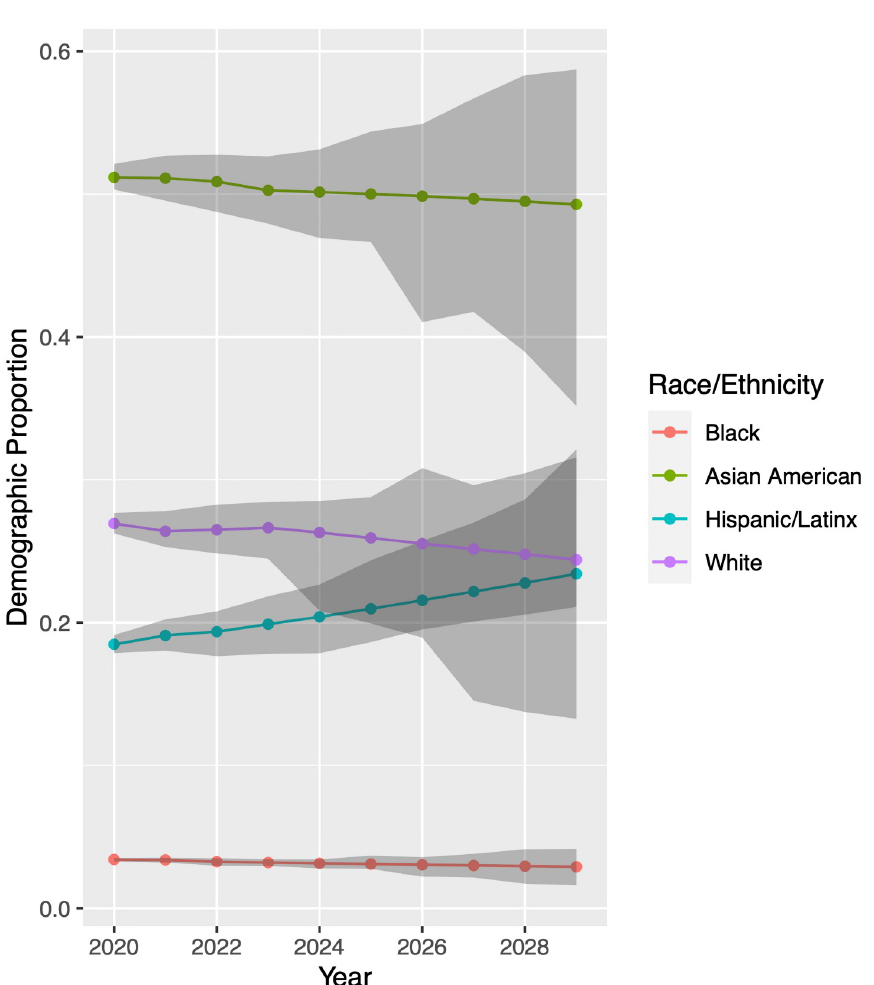
Fig 7. Model predictions for University of California-Berkeley. While the uncertainty in prediction is large after four to five years due to the difficulty in extrapolating model input parameters, two trends are clear. The proportion of Hispanic/Latinx students will rise, and the proportion of Black students will remain quite low. Colored dots are model output obtained when using the parameters forecast in Inferring Model Parameters. We perform an additional 2800 model simulations using parameter sets generated by Latin hypercube sampling. Grey bands indicate the central 95% of these results. Demographic proportions are relative to each other; see Mathematical Model.